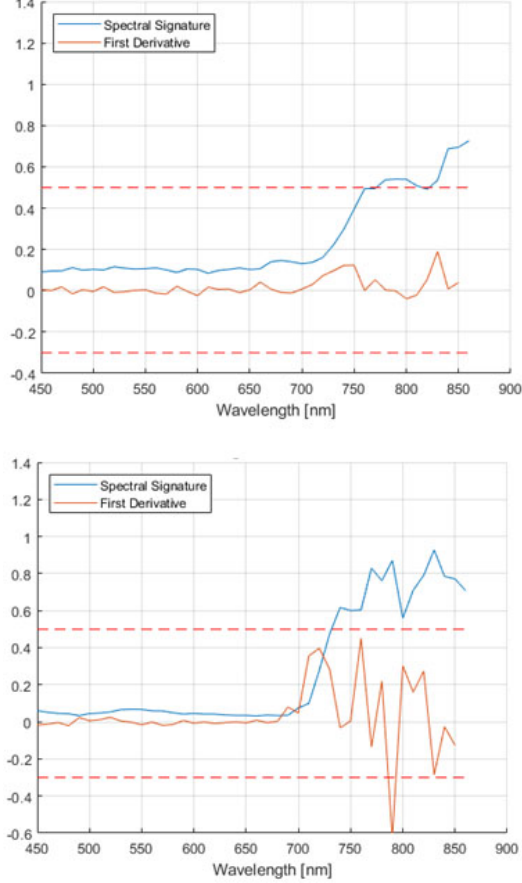
Figure 5. Mask using spectral gradient analysis. The original spectrum of a pixel (blue) and its derivative (orange)